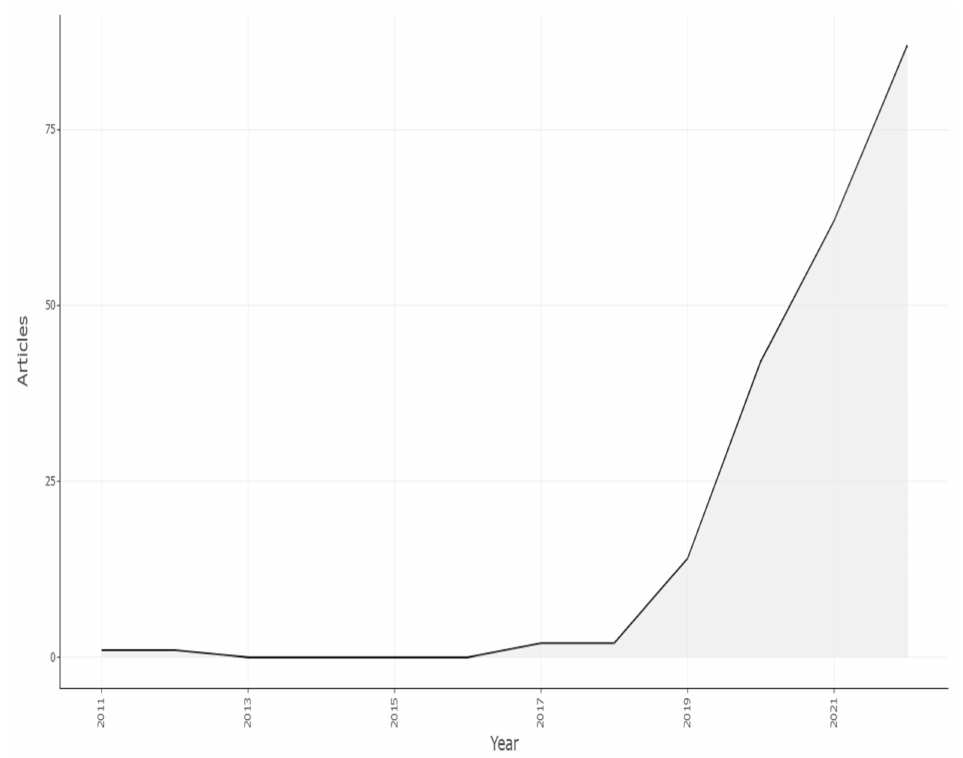
Figure 13. Scientific Article Production by Year. Data access information source: http://www.scopus. com (accessed on 14 September